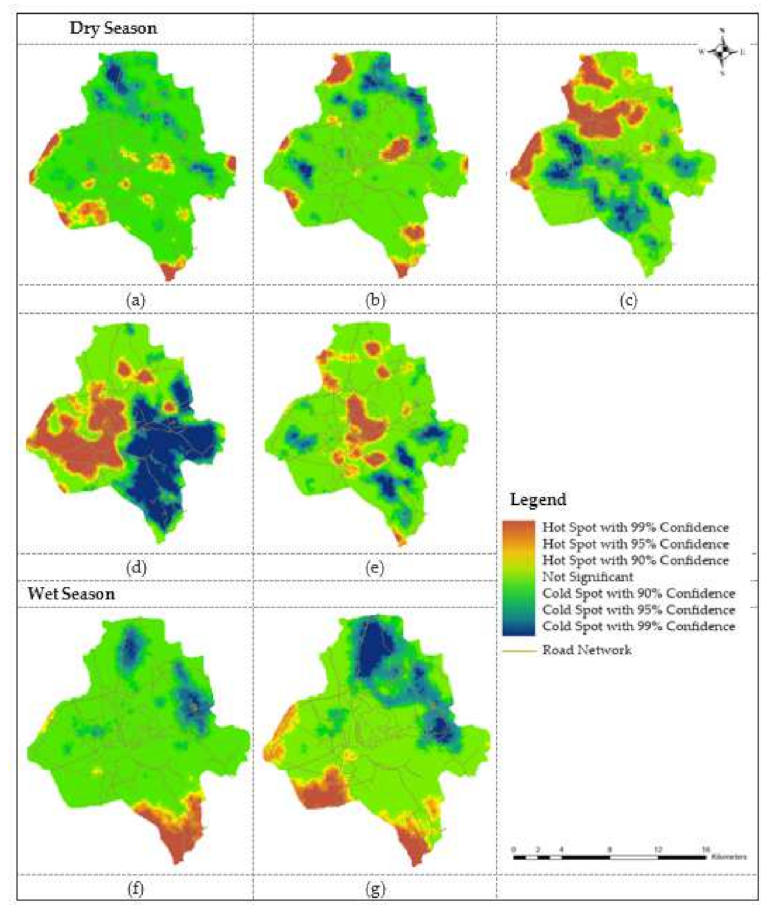
Figure 5. AOD hotspot and coldspot maps for Kampala District at the time of satellite overpass. ( a – e ) Hotspot and coldspot areas of images within the dry season months of December, February and January (i.e., on 31 December 2019, 9 February 2020, 9 February 2020 (OLI), 29 January 2021 and 28 February 2021, respectively). ( f , g ) Hotspot and coldspot areas of images acquired in the wet season months of September and March (i.e., on 21 September 2020 and 25 March 2021,